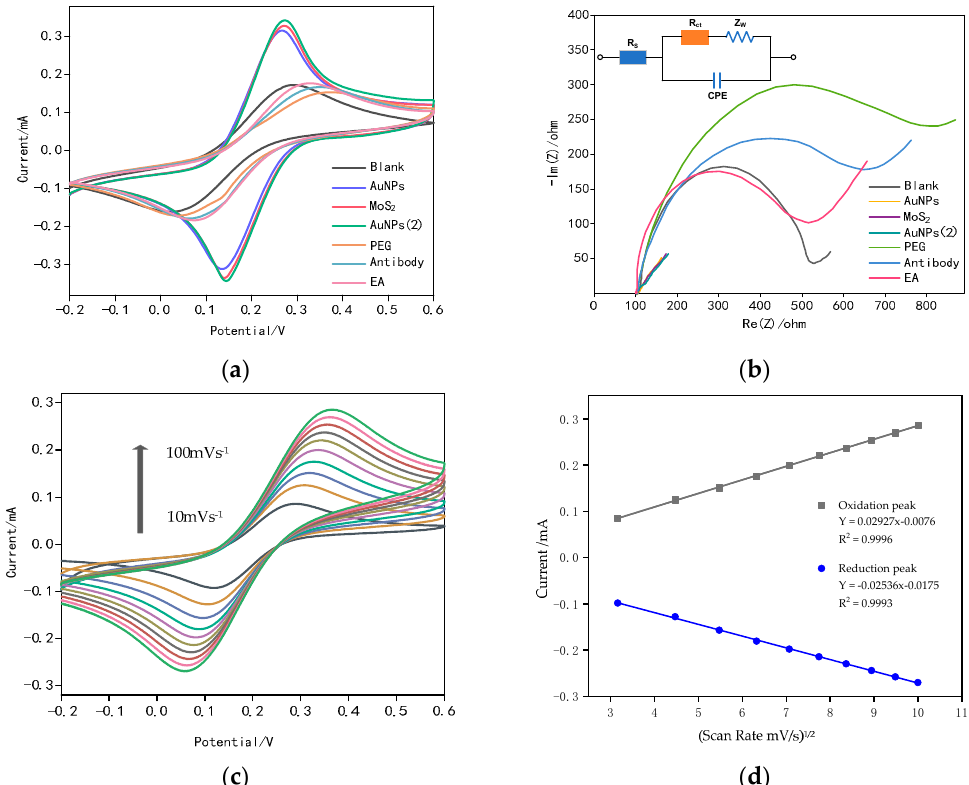
Figure 4. Characterization of the prepared immunosensor. ( a ) cyclic voltammetry (CV) curves of the proposed EA/CORT-Ab/SH-PEG-COOH/AuNPs/MoS 2 /AuNPs immunosnsor, ( b ) impedance spectra of AuNPs/MoS 2 /AuNPs-modified SPE, ( c ) CV curves of the proposed immunosensor in 5 mM redox couple with different scan rates (from inner to outer: 10 mVs − 1 − 100mVs − 1 ), ( d ) the dependence of redox peak currents vs. the square-root of the scan rate..